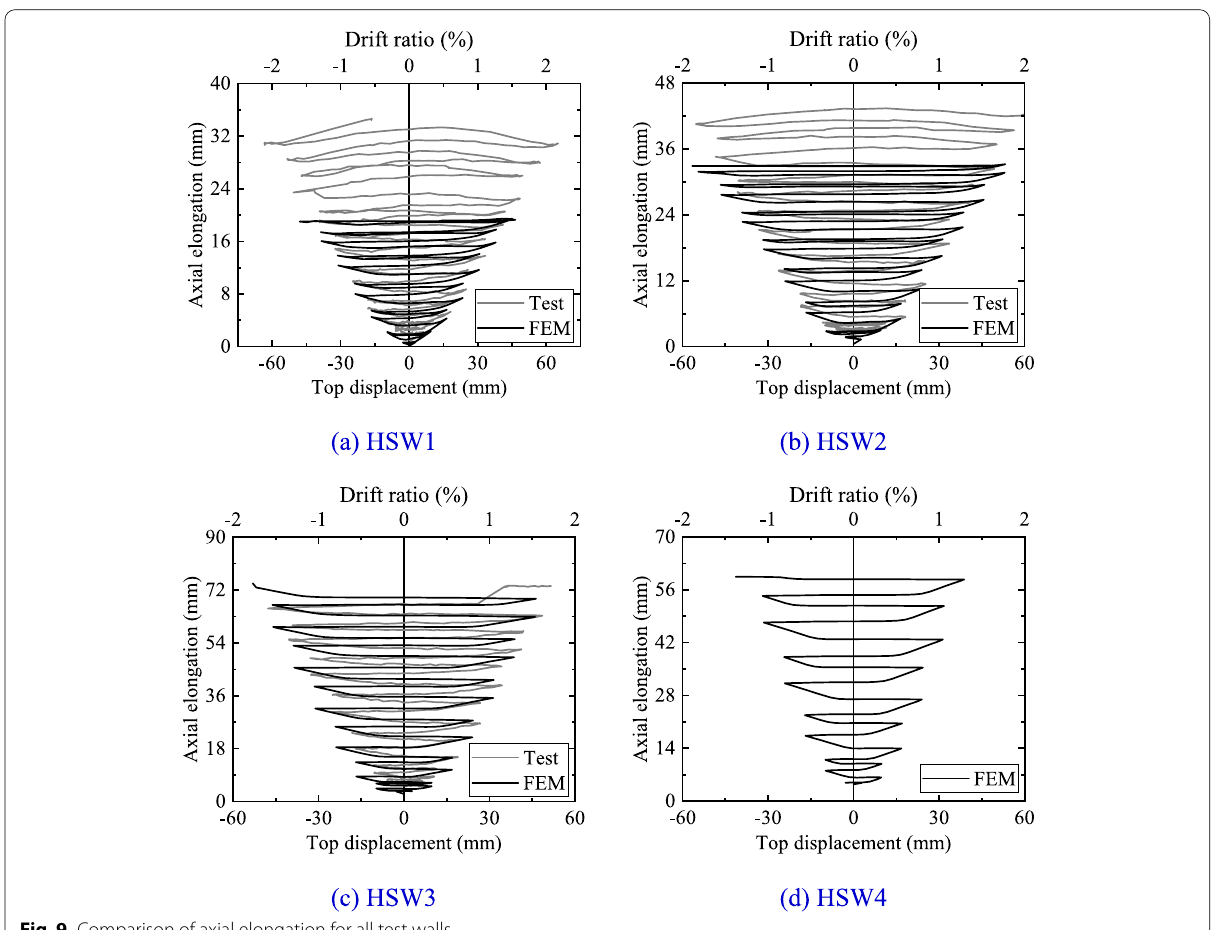
Fig. 9 Comparison of axial elongation for all test